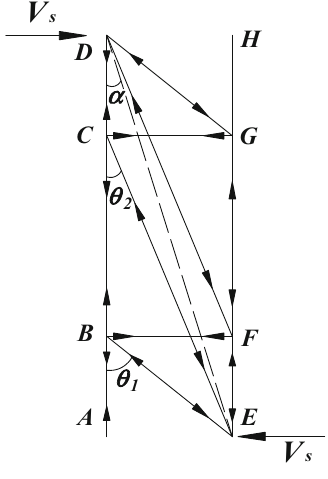
Fig. 5 Variable angle truss model by two-point Gauss